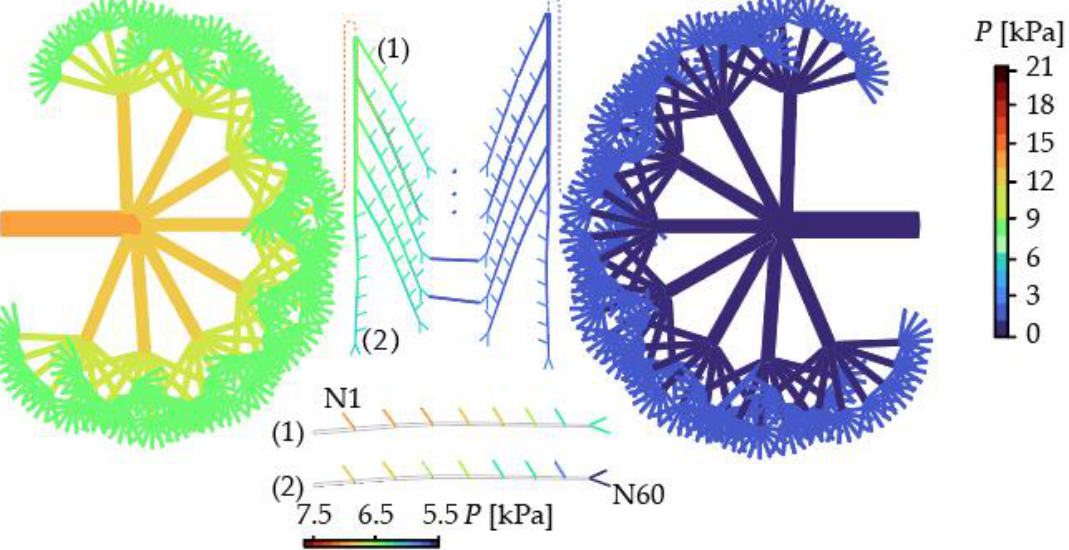
Figure 4. Simulation results of the entire renal vascular structure with P inlet = 13.0 kPa, visualizing pressure P . An extra enlarged view of the AAs is also illustrated. Every two generations of the symmetric branch is removed from the picture.